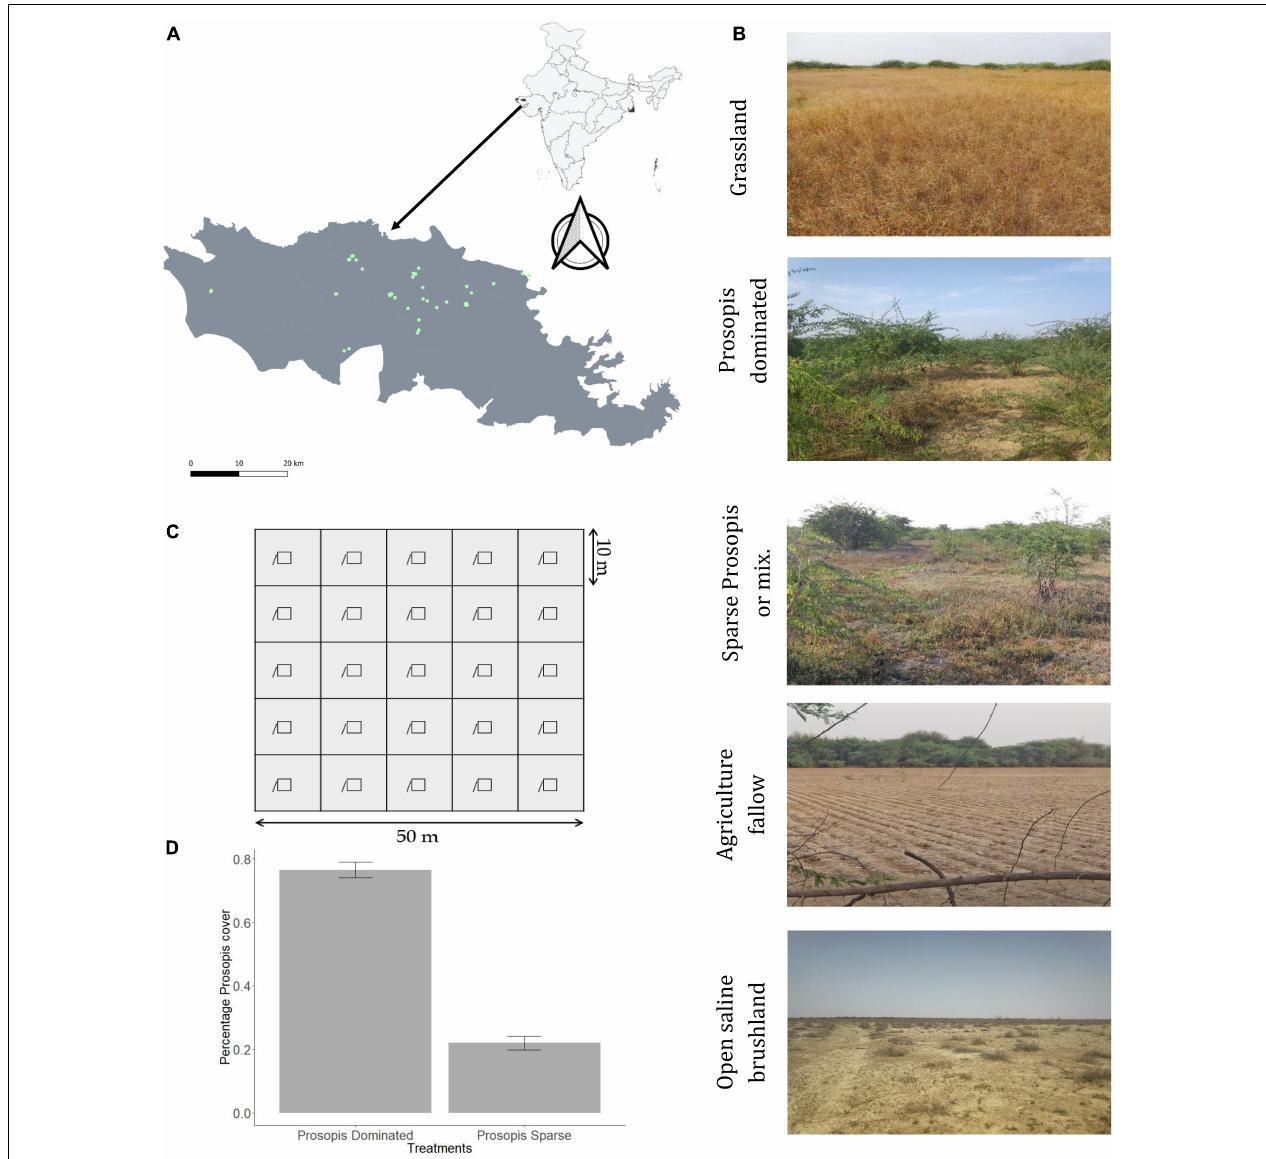
FIGURE 1 | Sampling schema. (A) Map of the study area (The Banni grassland) showing all the sampling sites as green points. (B) Representative photographs showing the physical structure of vegetation of each type of habitat. (C) Diagram depicting trap arrangements in each 50 × 50 m plot. (D) Difference in mean percentage Prosopis cover between Prosopis sparse (mean = 0.22, S.E. = 0.021) and Prosopis dominated (mean = 0.77, S.E. = 0.025) sampling